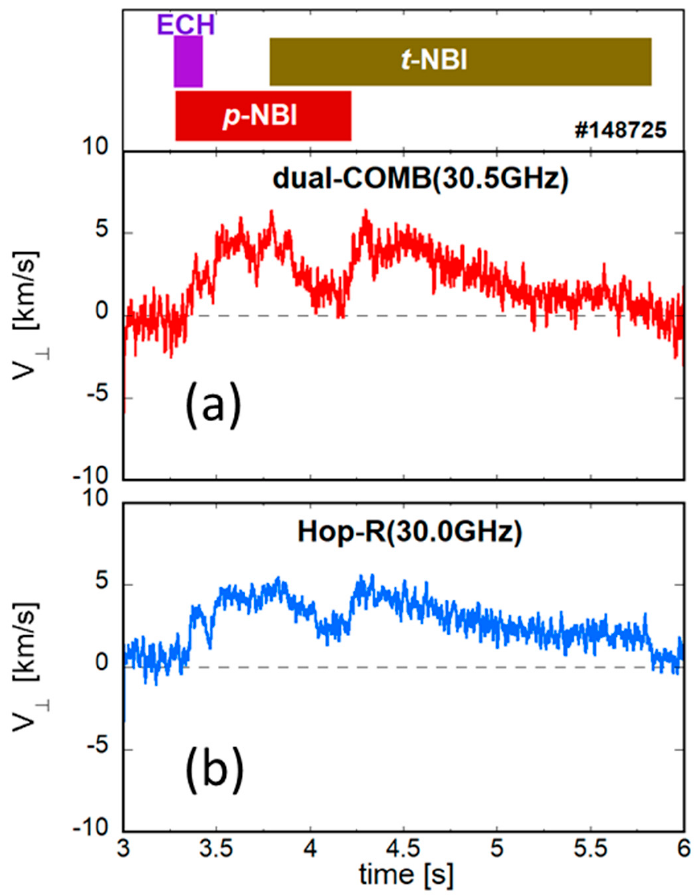
Figure 12. Temporal behavior of plasma perpendicular flow velocity obtained with ( a ) dual comb system at 30.5 GHz and ( b ) frequency-hopping Doppler reflectometer system operated at fixed 30.0 GHz, respectively. Shot number of LHD plasma is #148725. The injection timing of heating power for ECH, p-NBI, and t-NBI is shown above in color bar.